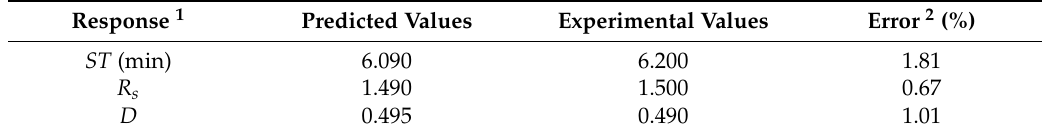
Table 3. Experimental and predicted responses under optimal conditions.